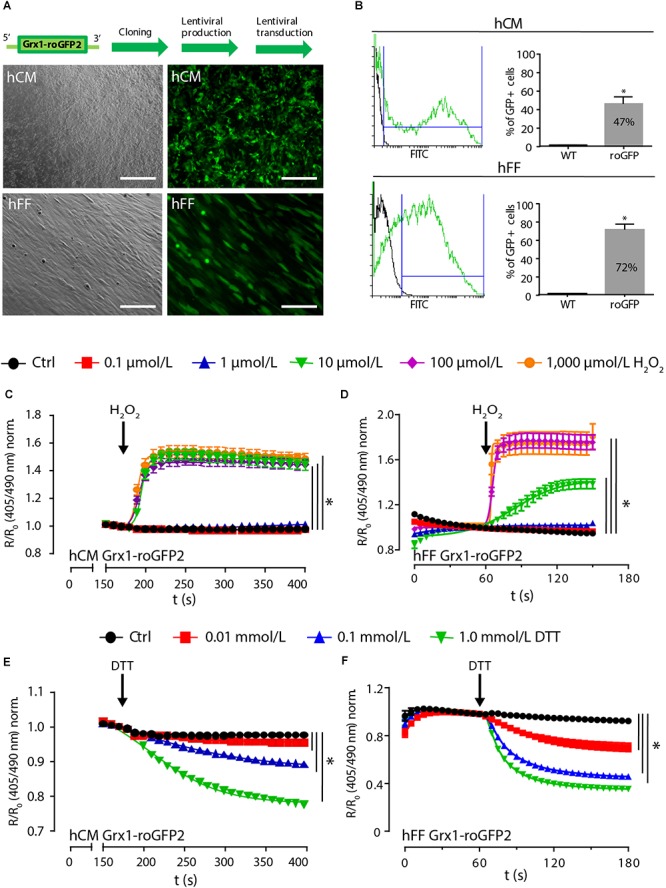
Lentiviral expression of Grx1-roGFP2 reports redox changes in differentiated cardiomyocytes and fibroblasts. (A) Brightfield (left) and GFP fluorescence (right) images after lentiviral transduction of hCM and hFF; scale bars: 200 μm. (B) Flow cytometry analysis of transduction efficiency in hCM (47 ± 7%, n = 7) and hFF (72 ± 6%, n = 8); ∗p < 0.05, unpaired, two-tailed Student’s t-test. Change of roGFP2 fluorescence signal in hCM (C) and hFF (D) as a function of time under oxidation by H2O2 at indicated concentrations (n = 46–71 [hCM]; n = 19–43 [hFF]). Change of roGFP2 fluorescence signal in hCM (E) and hFF (F) as a function of time under reduction by DTT at indicated concentrations (n = 46–85 [hCM]; n = 21–37 [hFF]).